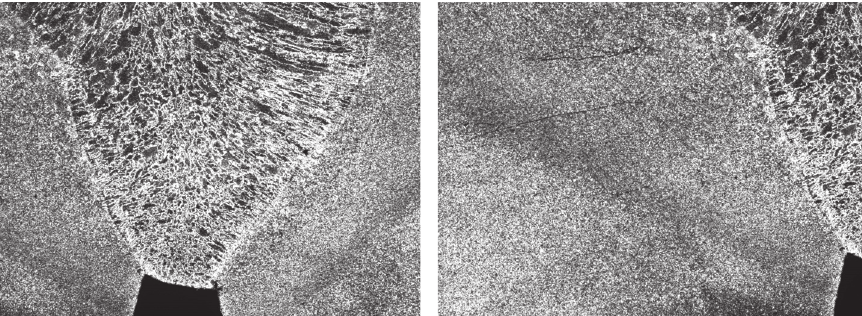
Figure 12: Welding in correspondence of micro-alloyed steel S355J0: the effects of HAZ are negligible; the typical band structure with following variations of grain size are